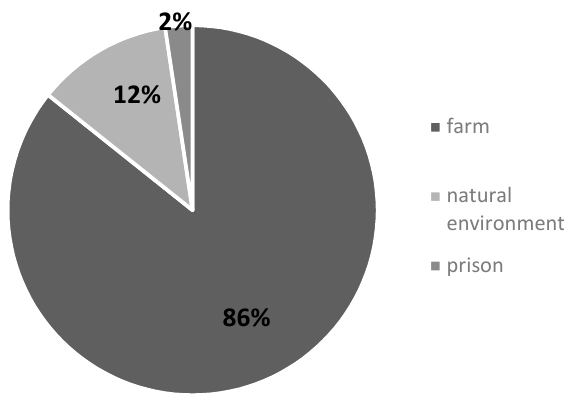
Figure 4. Percentage of different settings ( n = 42).